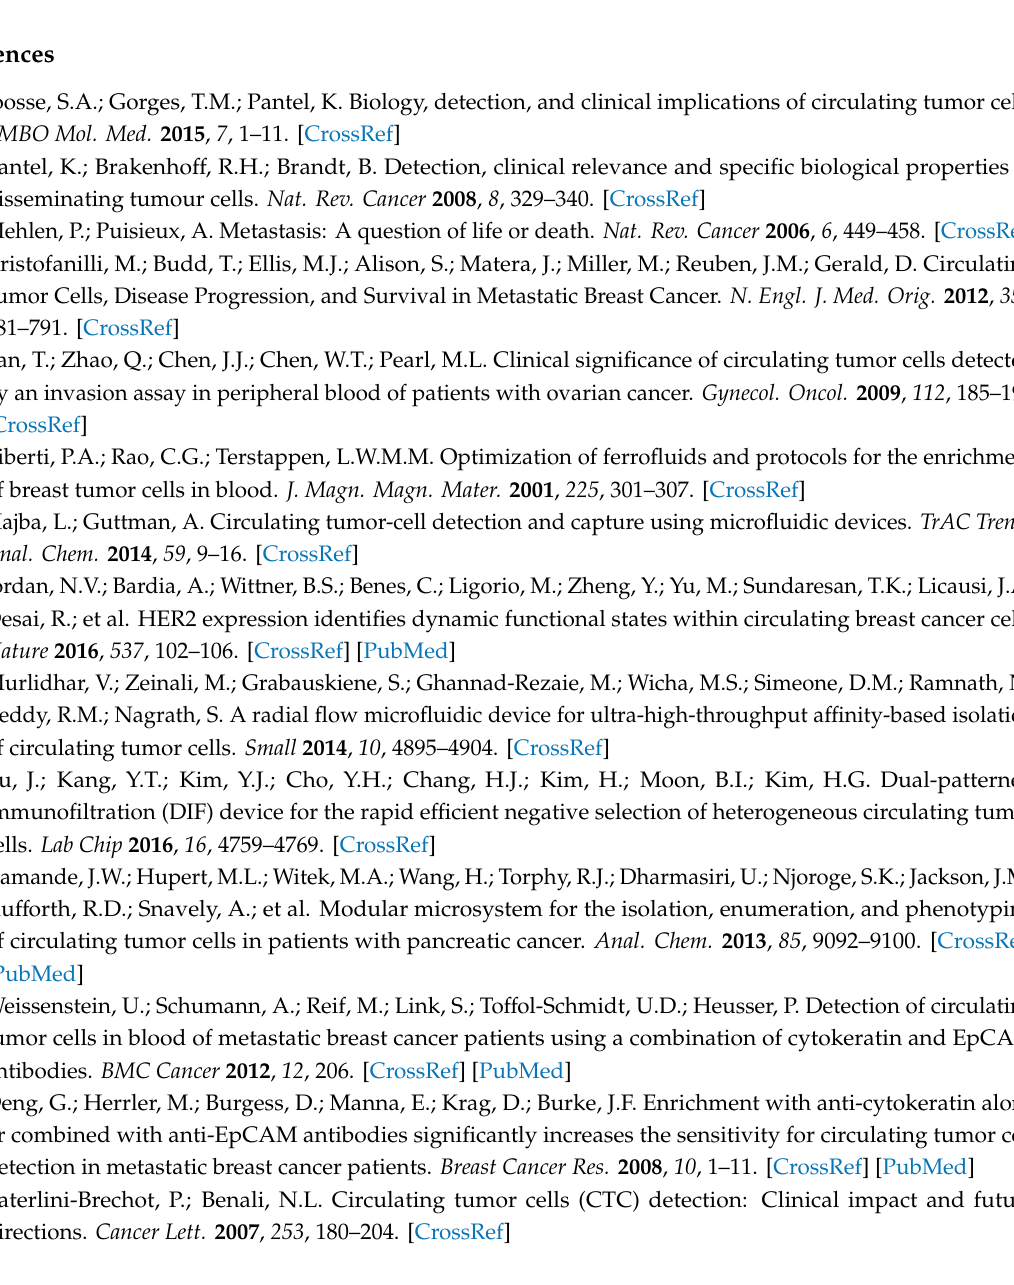
Figure S1: Scheme of the magnetically controlled SERS-based microfluidic setup, Figure S2: The morphology of SERS-active substrates (Ag / FLS) were visualized by the scanning electron microscopy (SEM), Figure S3: SERS spectra of p -MBA (10 − 6 M) adsorbed on the surface of the platform, recorded for the Ag / FLS substrates, Figure S4: The real photo of the microfluidic system connected with syringe pumps, Figure S5: Supplementary data for the Western blot analysis shown in Figure 1 in the main text, Table S1: Summarizes band assignments for the normal Raman and SERS spectrum of p